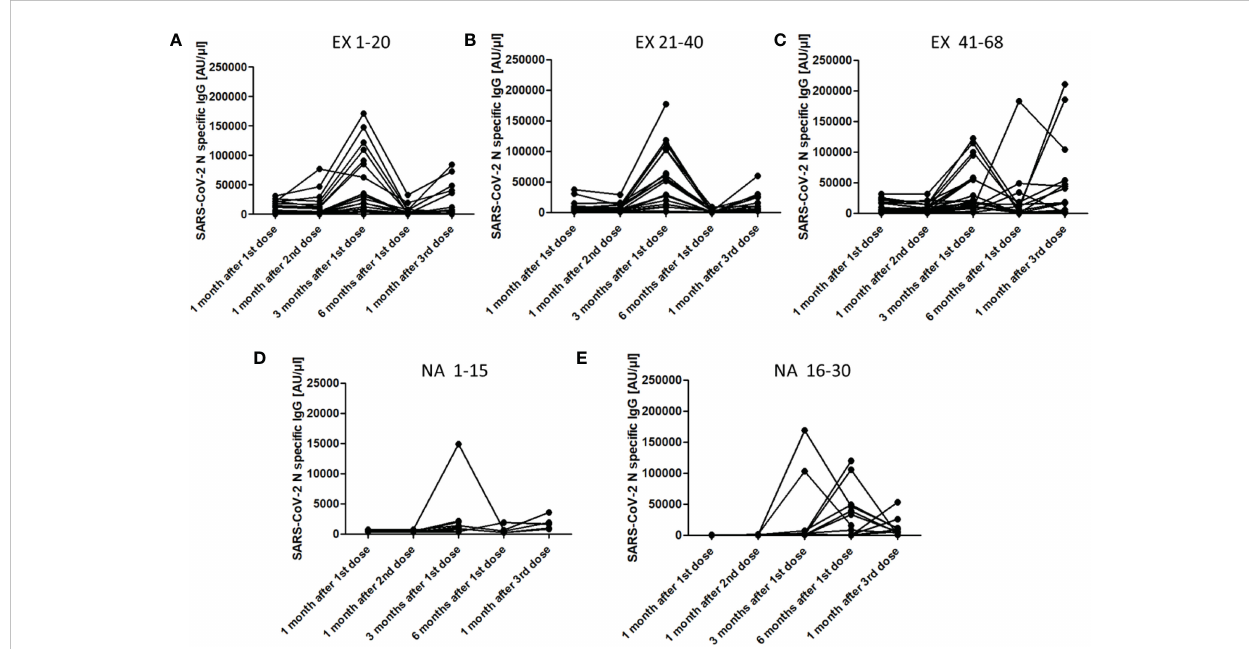
FIGURE 4 IgG levels [AU/µl] (arbitrary units/µl) against the N antigen of SARS-CoV-2 in each person included in both the experienced and naïve elderly groups. (A) , Experienced individuals from 1 to 20; (B) , Experienced individuals from 21 to 40; (C) , Experienced individuals from 41 to 68; (D) , Naïve individuals from 1 to 15; (E) , Naïve individuals from 16 to 30. The number indicates the individual position of each person in the study.